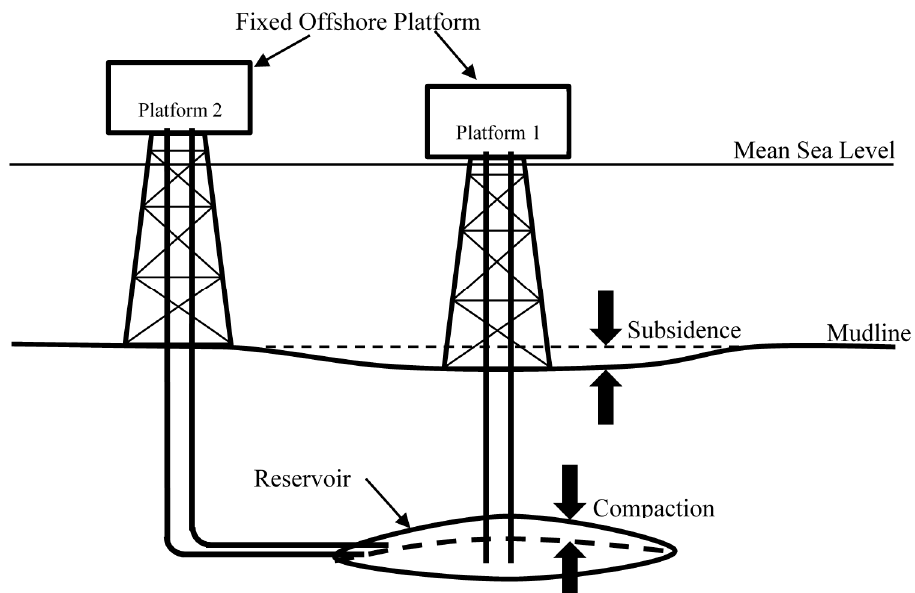
Figure 1. Offshore platform with and without subsidence.